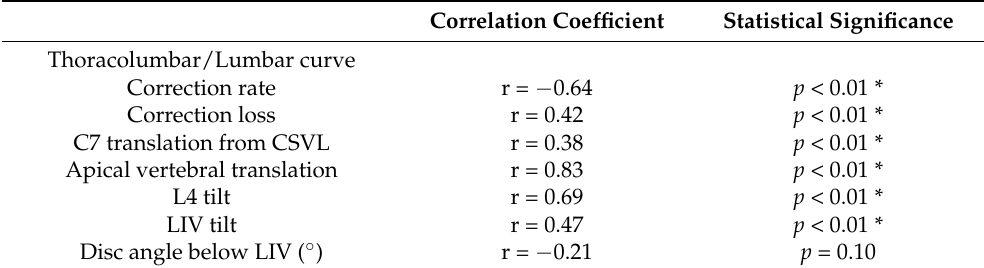
Table 4. Correlation analysis between LIV translation from CSVL and radiographic parameters at final follow-up.